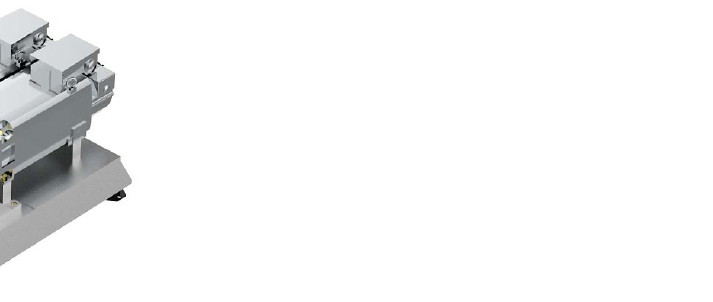
Figure 2. The eCVT test bench at the testing facilities of Siemens Industry Software.